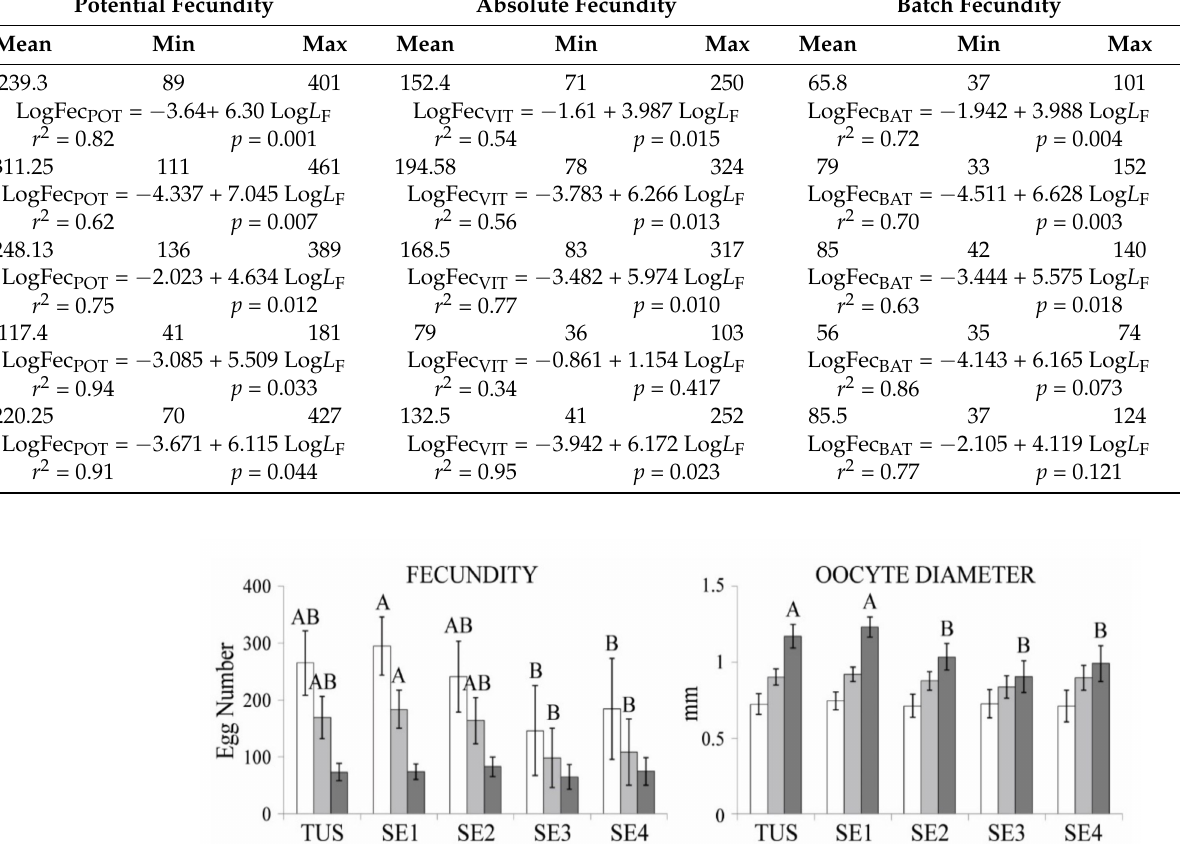
Table 3. Mean, minimum and maximum values of potential fecundity (Fec POT ), absolute fecundity (Fec ABS ) and batch fecundity (Fec BAT ) of Gobio lozanoi . Linear regression of fecundities and fork length ( L F ) are shown (significant p -values are included). Codes of sampling sites (TUS, SE1, SE2, SE3, and SE4) from the Segura River Basin were included.